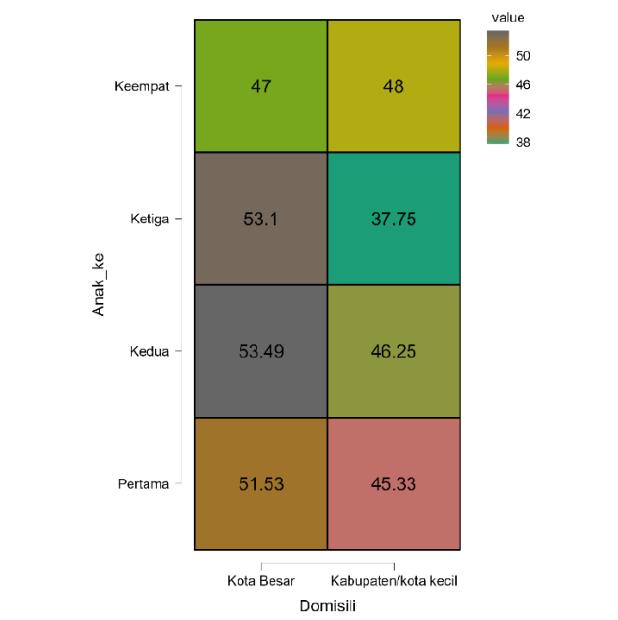
Figure 3. Heatmaps of Social Media Addiction Based on Social